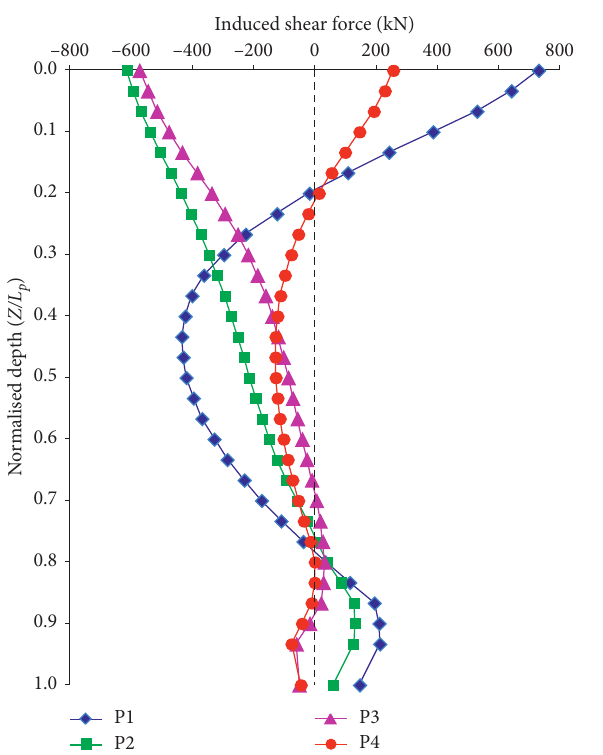
Figure 13: Induced bending moment along four piles (i.e., P1, P2, P3, and